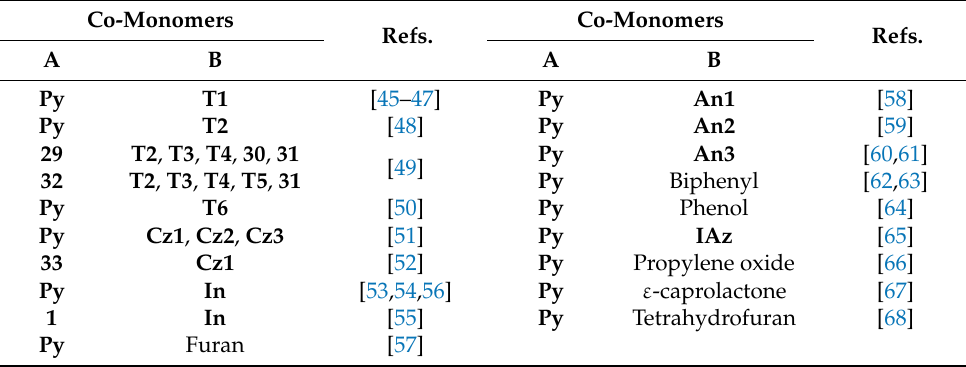
Table 2. Summary of co-monomer combinations involving non-pyrrole co-monomers used for copolymerisation. Co-Monomers